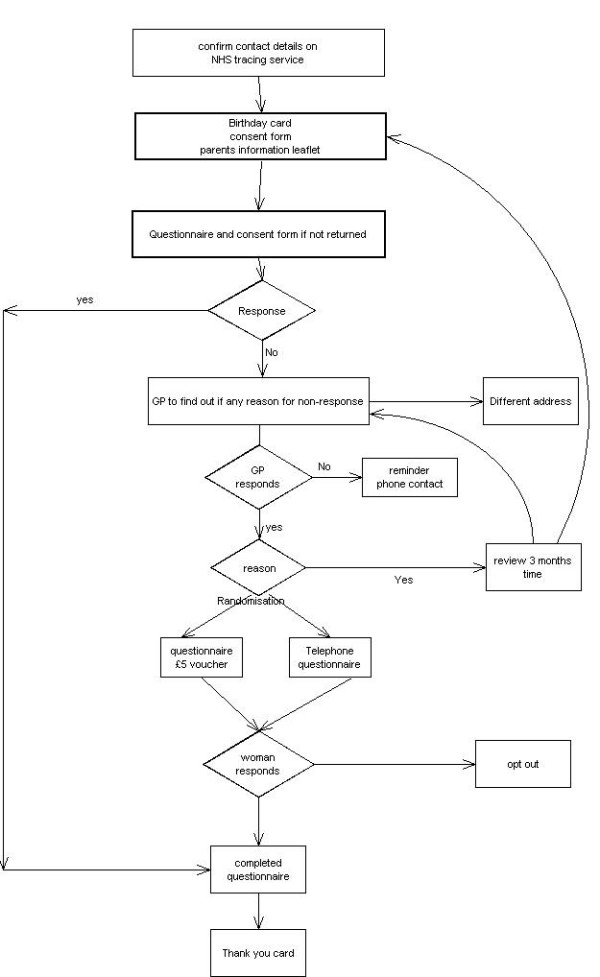
Child in 7th year.